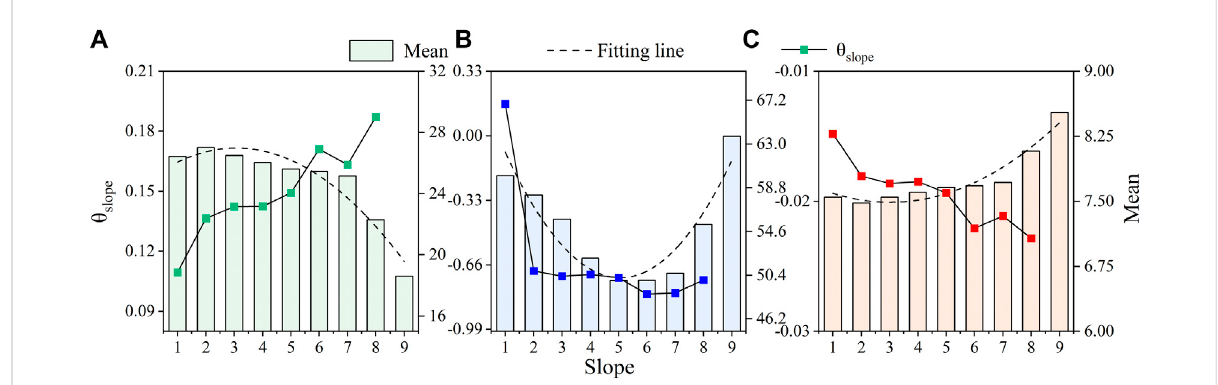
FIGURE 10 Effect of slope on soil water – salt: (A) effect of slope on SWC, (B) effect of slope on EC, and (C) effect of slope on pH. Note: 1 – 21 respectively represent 0 ° – 4 ° , 4 ° – 8 ° , 8 ° – 12 ° , ... 32 ° – 36 ° , 36 ° – 40 ° , > 40 ° ; constrained conditions: elevation of 3,400 – 3,600 m and aspect of southern.